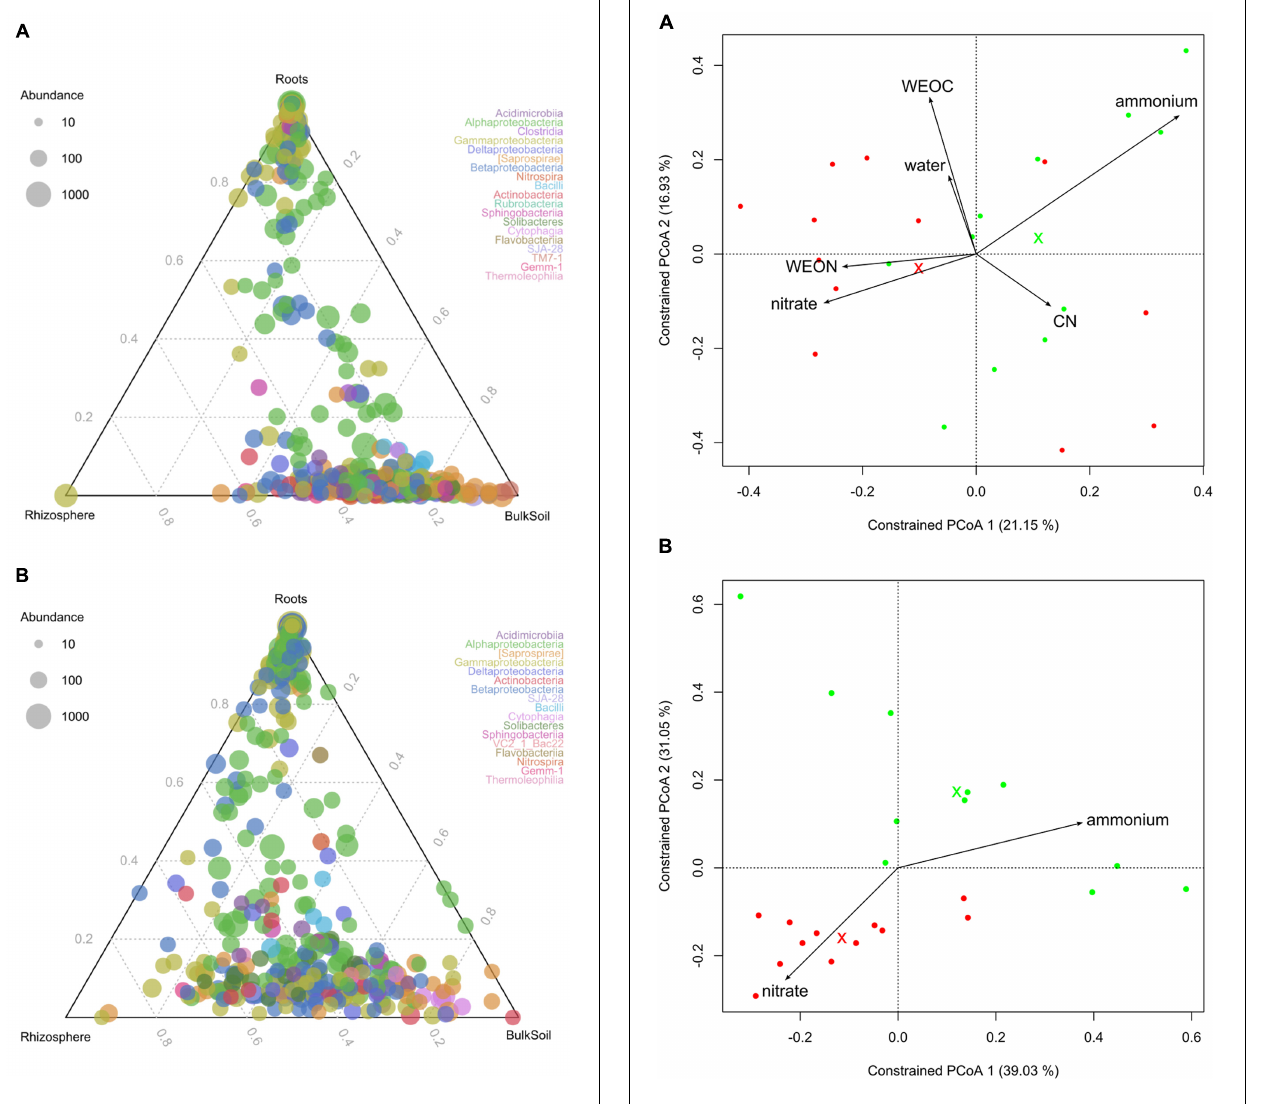
FIGURE 3 | Canonical analysis of principal coordinates of Bray–Curtis dissimilarities in roots. Crosses mark centroids of low or high LUI, respectively. Low LUI is represented in green, high LUI is represented in red color. (A) Using soil characteristics as constraints. Constraints reflect 36% of overall variance in the data (PERMANOVA, p < 0.003; 95% confidence interval), (B) using soil nitrate and ammonium as constrains independent from other